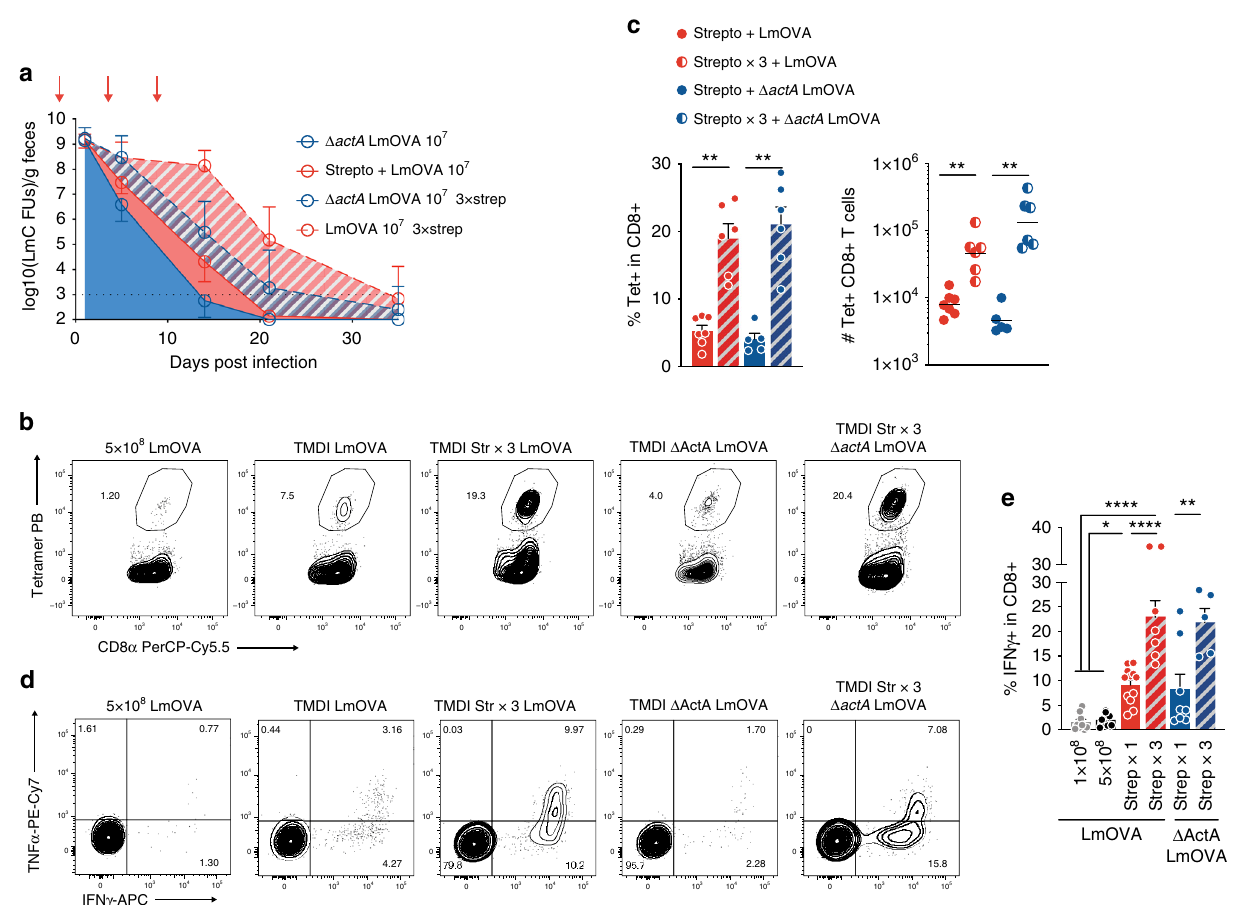
Fig. 3 Recurrent impairment of microbiota recovery further enhances generation of functional CD8 + Trm. a Intestinal expansion of LmOVA strains following repeated streptomycin treatments (indicated by arrows, d-1, d4, and d9), as measured by plating of fecal pellets ( n = at least 8 from at least 2 experiments per time point per group; shown are geometric means ± geometric SD). b Representative FACS plots showing percentage of tetramer-positive cells in the large intestine lamina propria at d50 following immunization with the depicted strategies. c Percentages and numbers of tetramer-positive CD8 + T cells in the LILP 50 days post immunization ( n = 5 – 7 from 2 independent experiments; one-way ANOVA with multiple comparisons; shown are means±SEM and geometric means, respectively. Data points shown for groups administered streptomycin once are a subset of those shown in Fig. 2d). d Representative FACS plots and e percentages of cytokine production in LILP cells obtained as in c , re-stimulated ex vivo in the presence of cognate peptide (SIINFEKL) and Brefeldin-A (for groups listed as in fi gure: n = 9, 8, 12, 7, 8, 5 from 3, 3, 3, 2, 3, 2 experiments, respectively; one-way ANOVA with multiple comparisons; shown are means±SEM). (For all analyses: * p <0.05, ** p <0.01, *** p <0.001, **** p